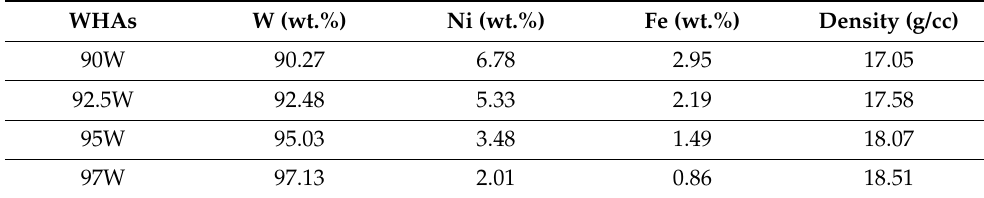
Table 1. The nominal compositions and density of the